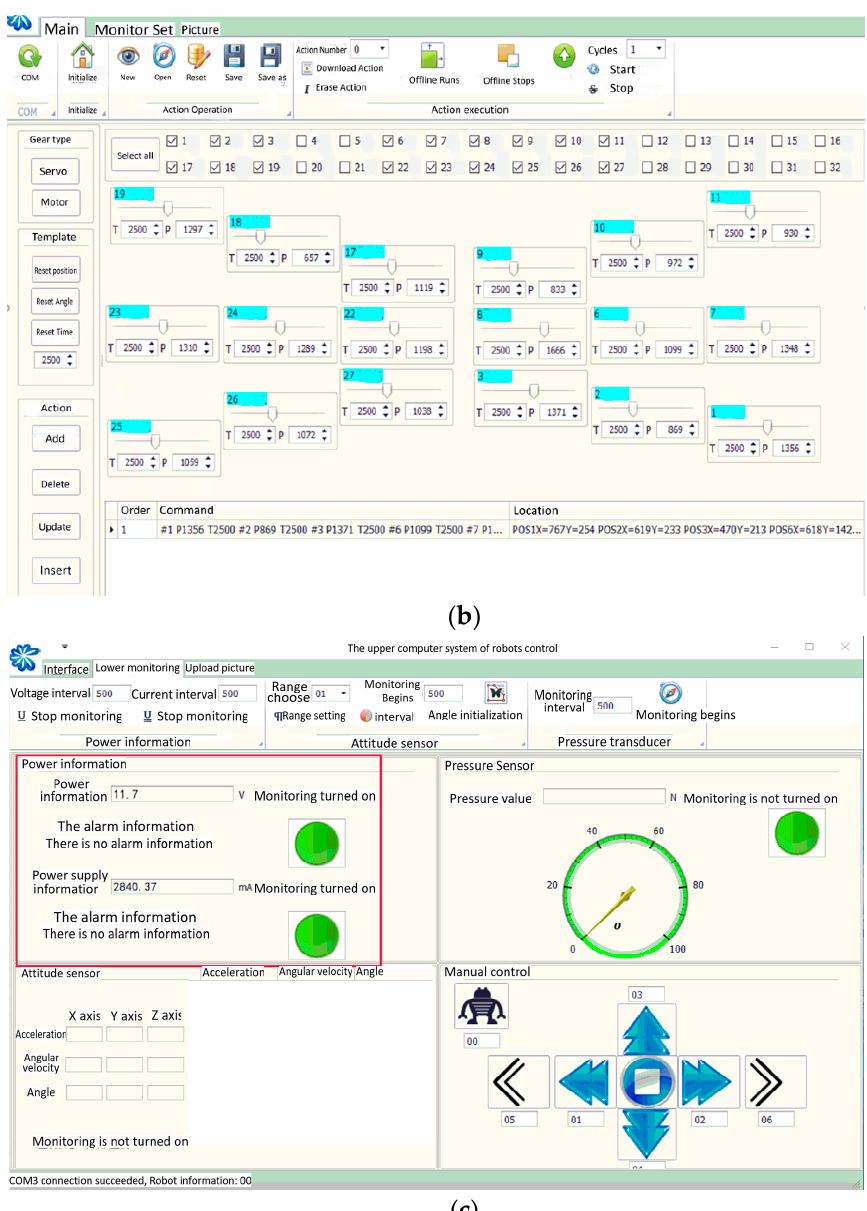
Figure 2. Experimental prototype and software: ( a ) hexapod robot prototype; ( b ) servo control interface; ( c ) upper monitor interface.